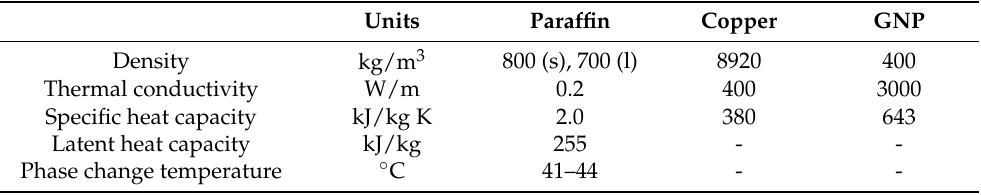
Table 1. Thermal and physical properties of materials involved in coupled enhanced LHS systems are provided below in the table and have been obtained from suppliers [39,40] and are in the public domain.